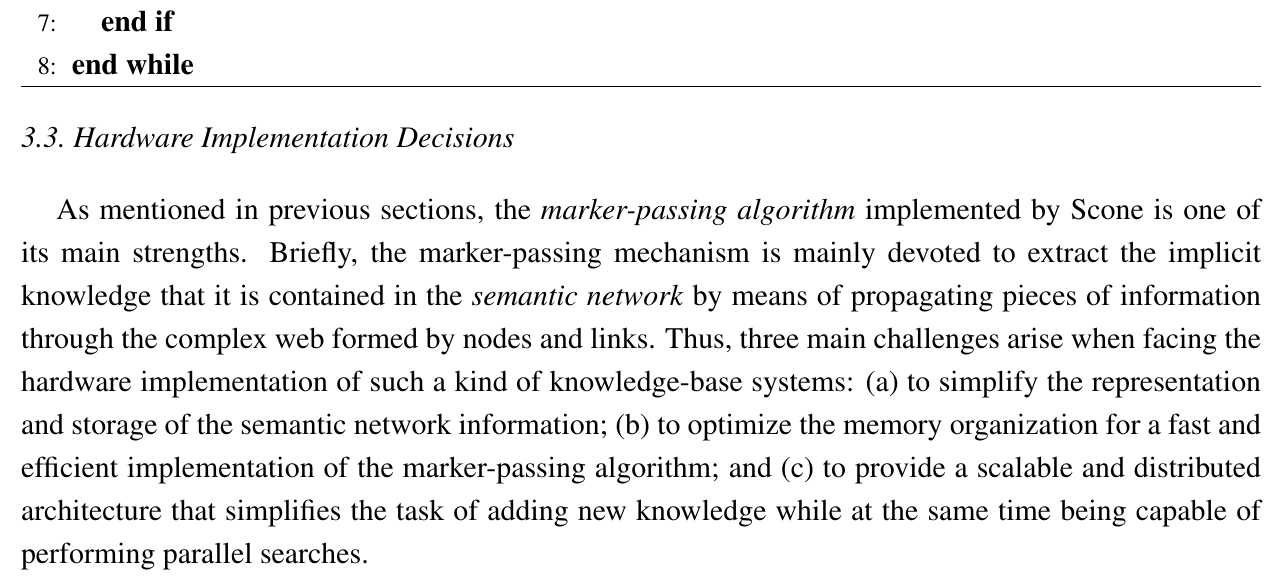
Figure 1. Architecture of the Scone